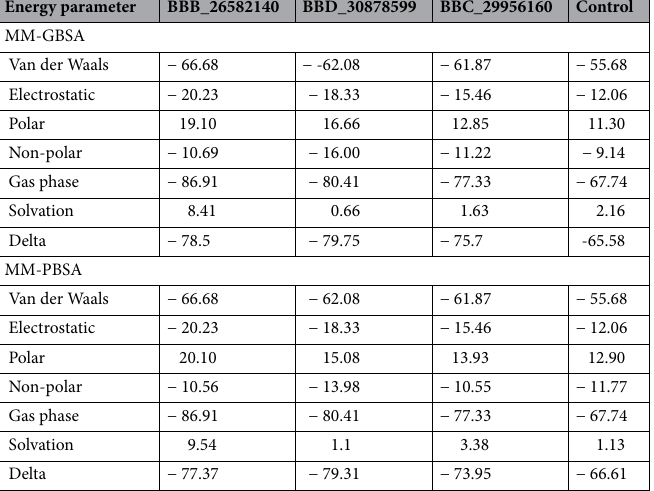
Table 1. MDS free energies analysis (kcal/mol).